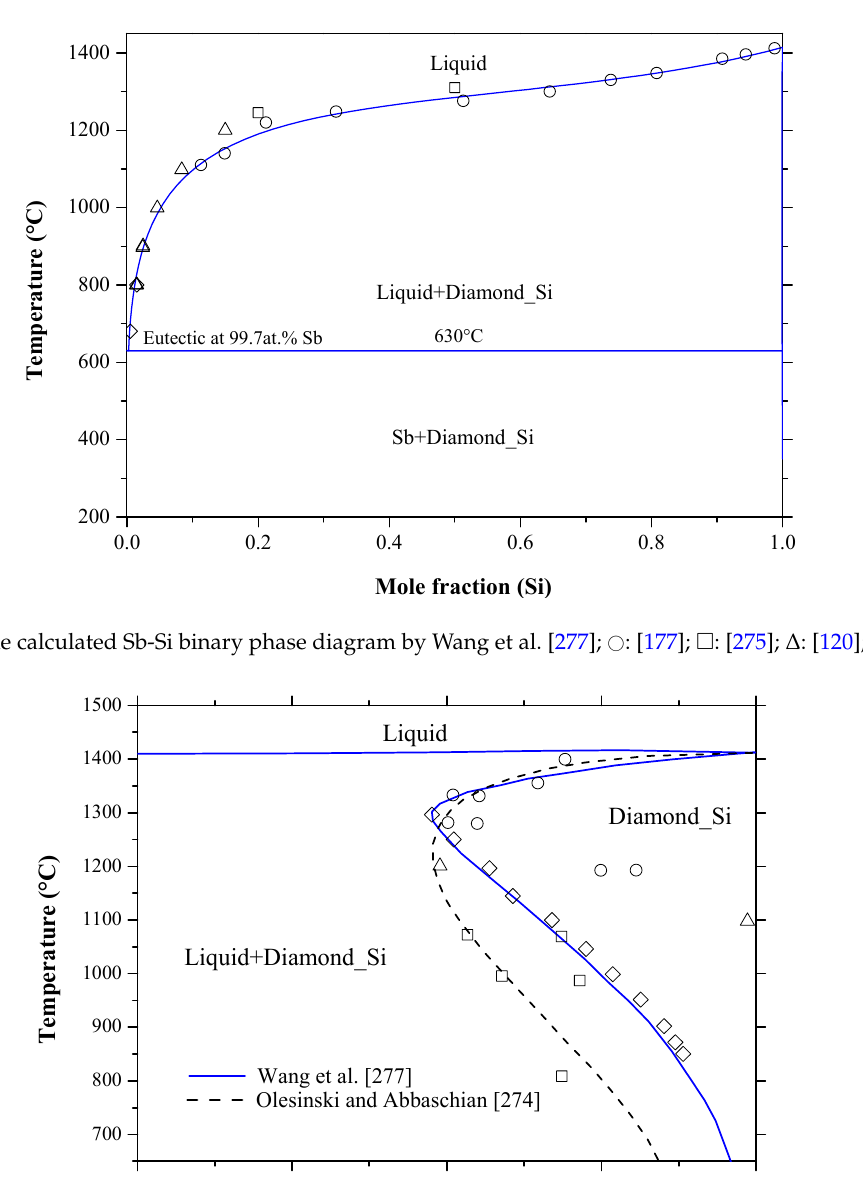
Figure 32. Magnified portion of the calculated Sb-Si phase diagram [277]; ----: [274]; Δ : [179]; ○ : [276]; □ : [118]; : [278].